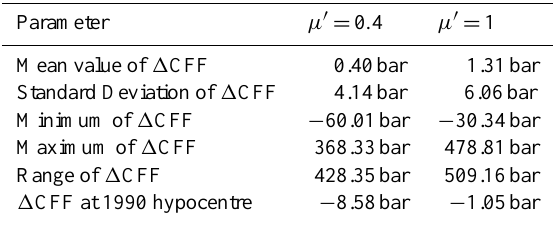
Table 4. Parameters of statistical analysis of 1 CFF for optimal planes at depth 131km, hypocentre area of 1986 event (40400 grid points). We can see that by increasing the coefficient of friction, 1 CFF is increased. For a graph view of the results see Fig. 3. For details of the method see Appendix A.